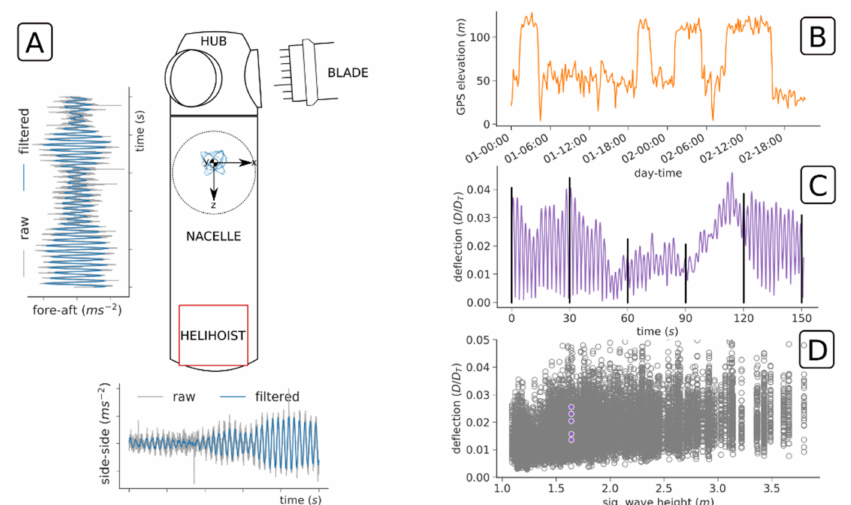
Figure 4. Data acquired by the motion sensor boxes installed on top of the nacelle. ( A ) the raw accelerations were filtered and numerically integrated twice, resulting in the trajectory of the nacelle in the seaplane. GNSS altitude tracks ( B ) recorded simultaneously at the blade lifting yoke reveal installation times. Calculating the absolute value of the locus vector of the nacelle results in the deflection, a measure for the amount of distance the nacelle has been moved from its resting position ( C ). Combining deflection and sea state data reveals the correlation between significant wave height and structural response in the form of deflection ( D ). Further details on the measurement campaign are provided by Sander et al. [7,8]. The measurement data is available at https://zenodo.org/record/ 4498779 (accessed on 8 June 2021) [9].